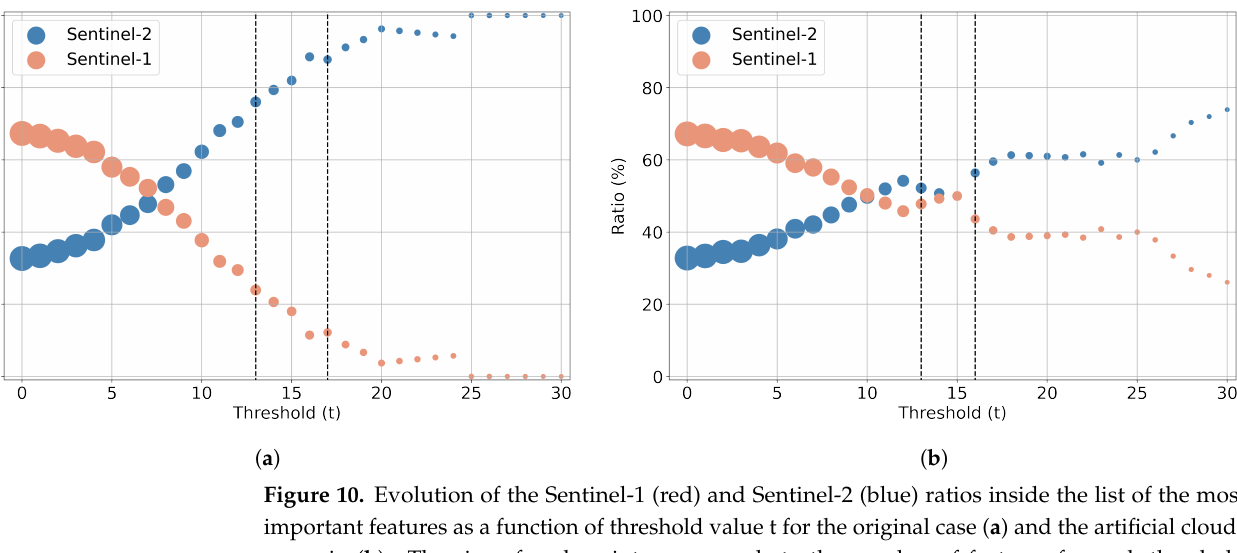
Figure 10. Evolution of the Sentinel-1 (red) and Sentinel-2 (blue) ratios inside the list of the most important features as a function of threshold value t for the original case ( a ) and the artificial clouds scenario ( b ). The size of each point corresponds to the number of features for each threshold considered. Black demarcation lines delineate the threshold range for the optimal performance of SVM classifier in each